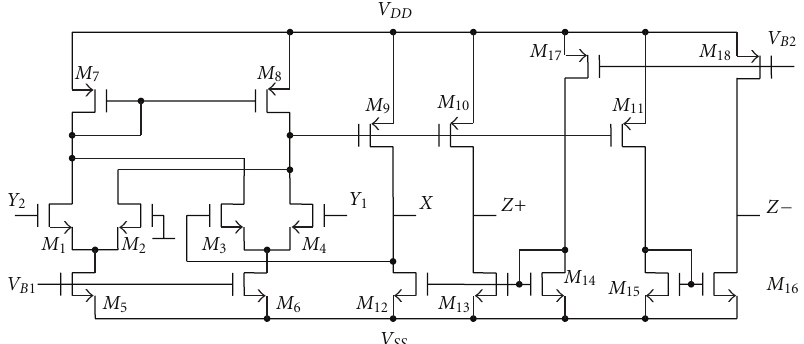
Figure 6: CMOS circuit of the DVCC used in the simulations [24].